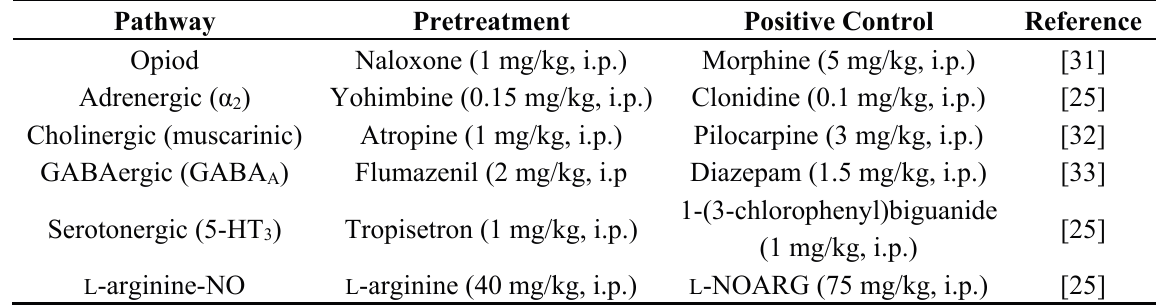
Table 1. Drugs used to evaluate the mechanism of antinociceptive action of caulerpine. Pathway